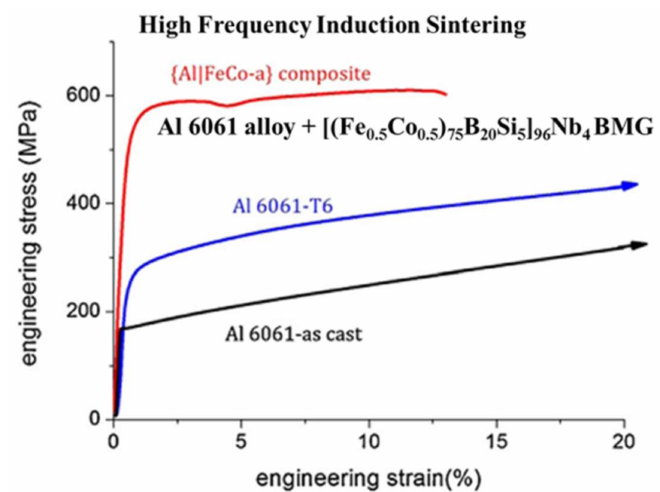
Figure 9. Compression stress–strain curves of high frequency induction sintered Al6061 alloy with [Fe 0.5 Co 0.5 ) 75 B 20 Si 5 ] 96 Nb 4 composite compared to those of Al 6061 commercial alloy in the as cast and T6 tempered conditions [31]. (© 2012, Elsevier. Used with